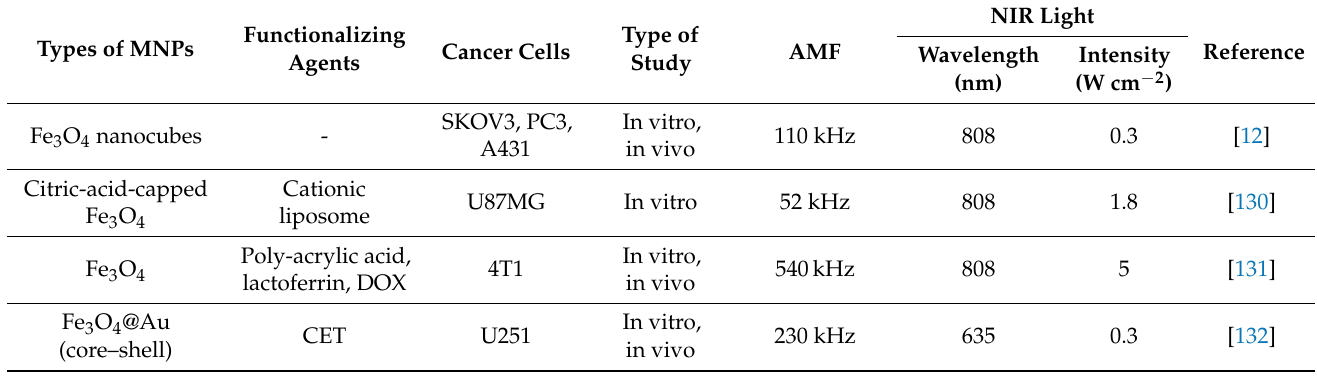
Table 3. Summary of the use of functionalized MNPs for AMF- or NIR-laser-induced cancer